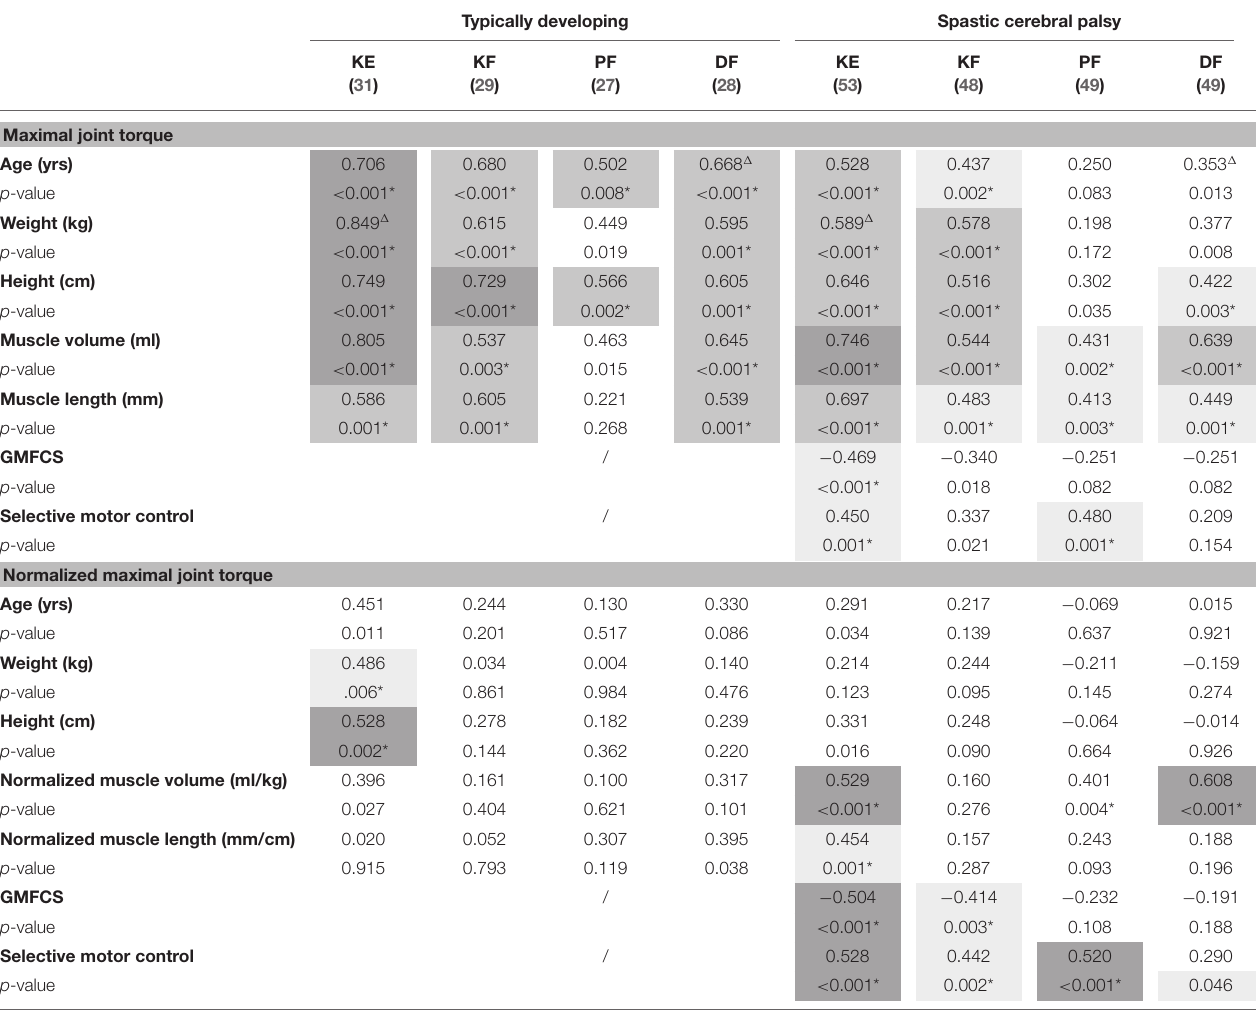
TABLE 3 | Associations with maximal joint torque. Typically developing Spastic cerebral